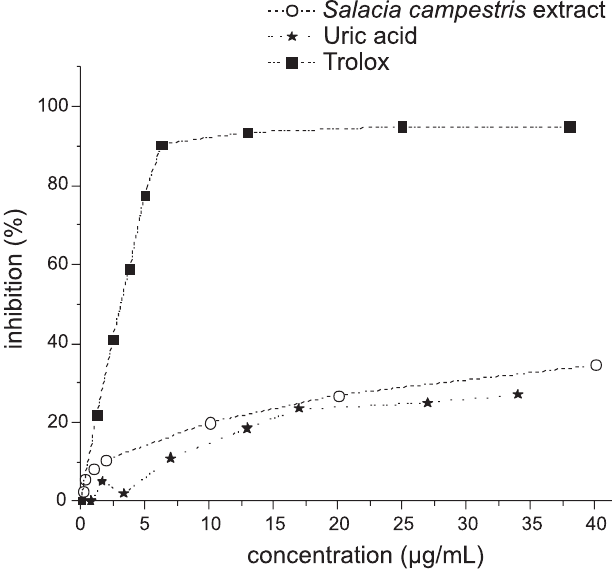
FIGURE 1 - DPPH radical (60 µM) scavenger action by S. campestris extract, uric acid and trolox. The reactions were made in ethanol, at 25 °C, and incubated by 15